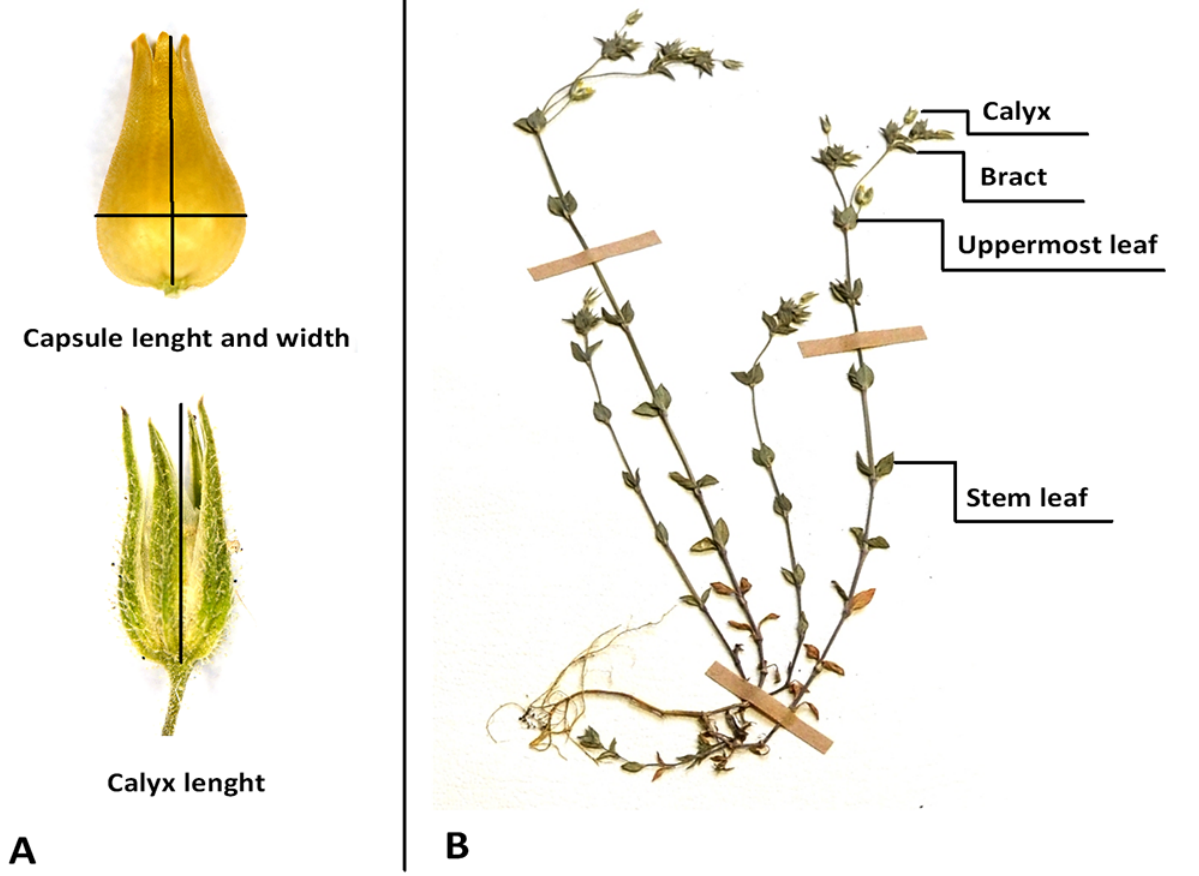
Fig. 1 Quantitative ( A ) and qualitative (type of indumentum on selected part of the plant) ( B ) characters used for